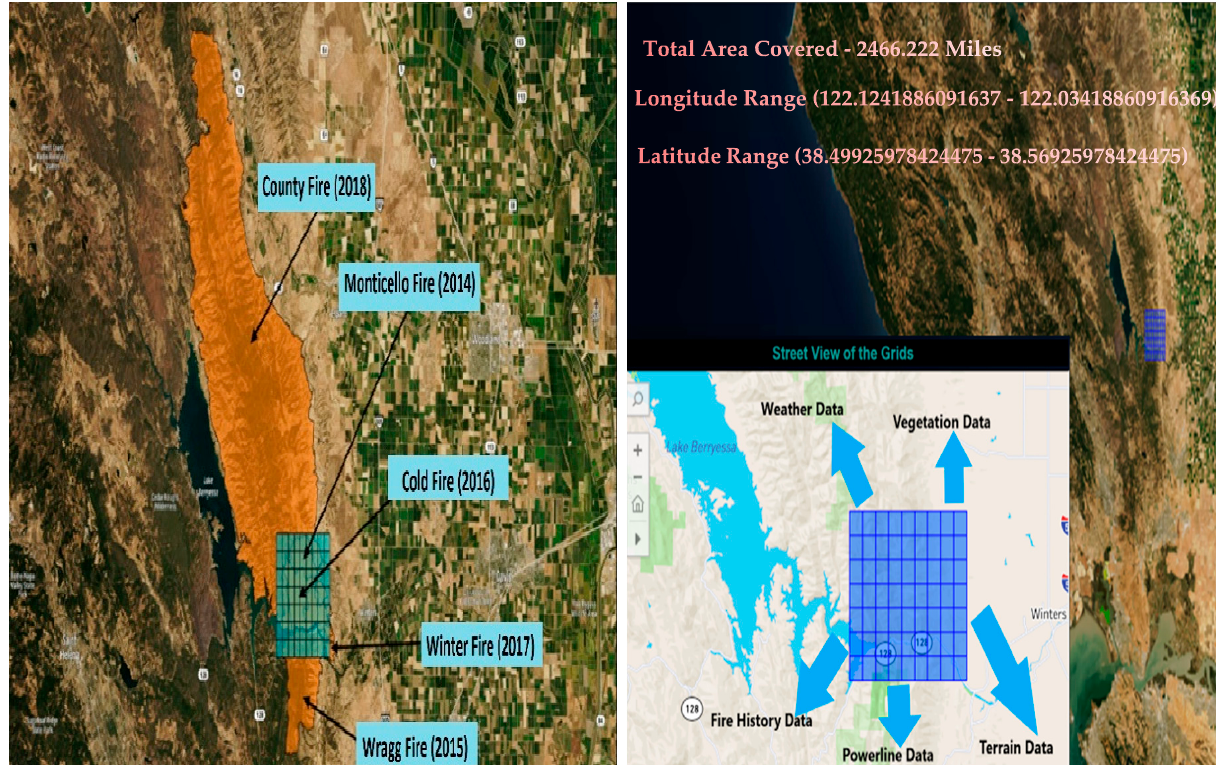
Figure 1. Integration of study area and Fire History (Monticello and Winters, California) .